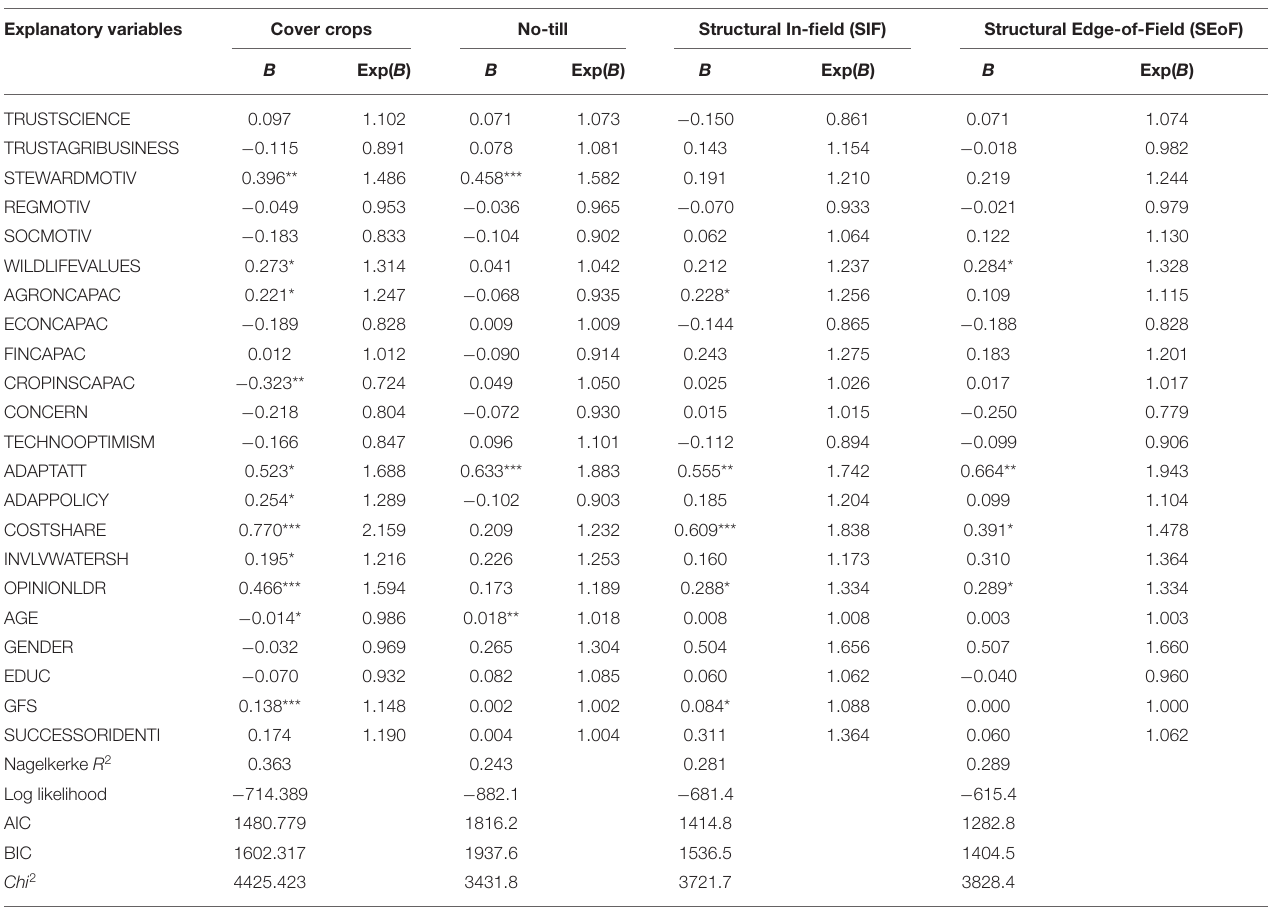
TABLE 3 | Factors that affect farmers’ adaptive actions to climate change and extreme weather impacts. Explanatory